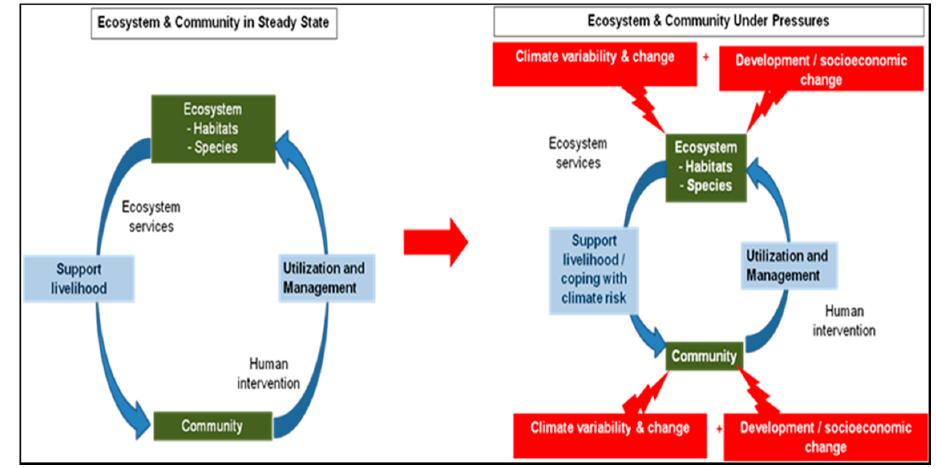
Figure 3. Conceptual framework of the inter-relationship between ecosystem and community [11].